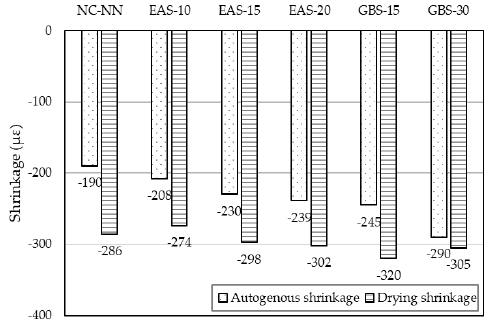
Figure 9. Shrinkage behavior under free conditions.